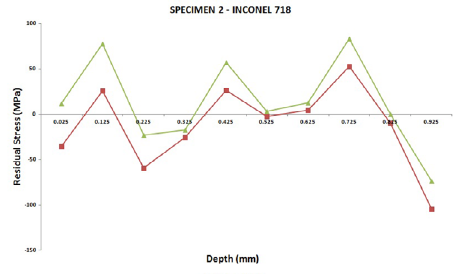
Figure 6. Distribution of the minimum and maximum residual stresses in specimen 2, contemplating the interface region between BM and HAZ of the Inconel 718 alloy.